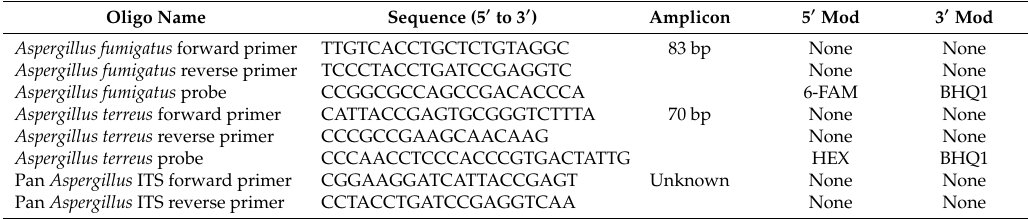
Table 4. Summary of all primers and probes used in this study. 6-FAM: 6-Carboxyfluorescein, BHQ1: Black Hole Quencher-1, ITS: internal transcribed spacer, Mod: